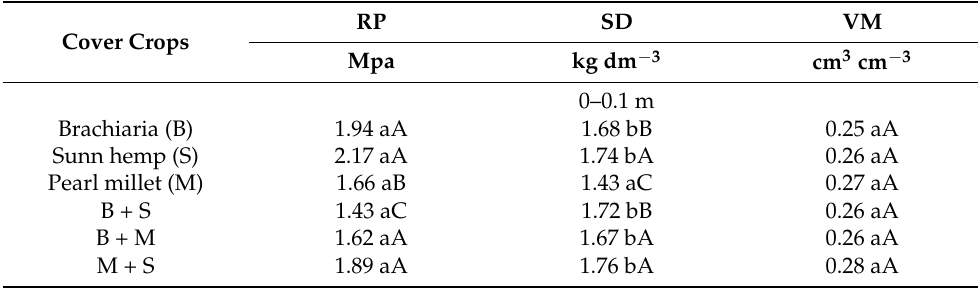
Table 1. Soil resistance to penetration (RP), soil bulk density (SD) and volumetric moisture (VM) in a Oxisol cultivated with different cover